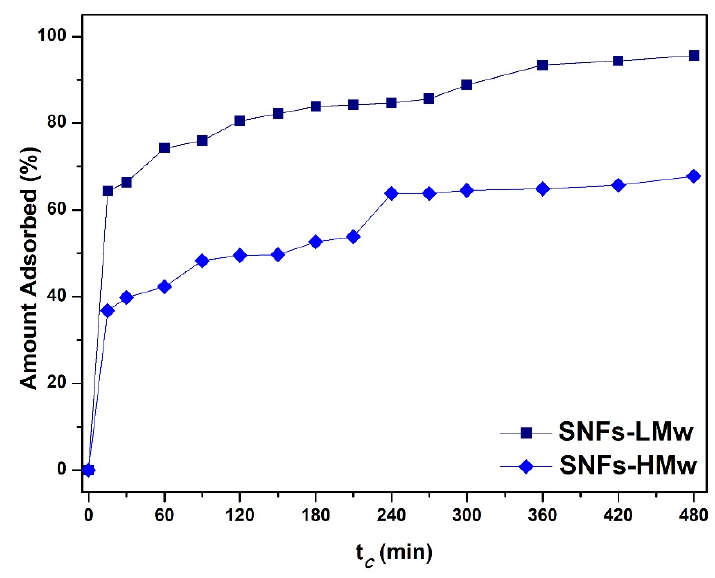
Figure 9. Effect of contact time on MB adsorption onto SNFs-LMw and SNFS-HMw. Table 4. Kinetic modeling results of MB adsorption onto SNFs-LMw and SNFs-HMw. Pseudo-First-Order